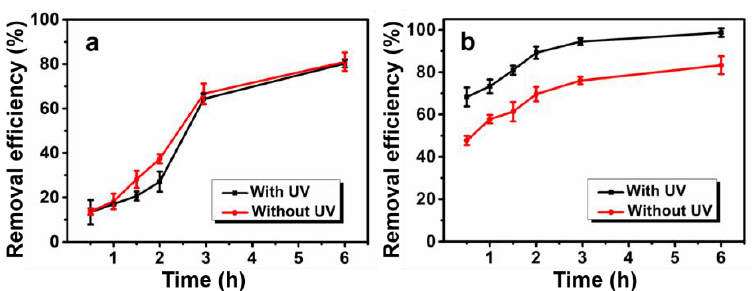
Figure 9. Effect of UV on dye degradation: ( a ) free laccase; ( b ) immobilized Lac. Figure 9. E ff ect of UV on dye degradation: ( a ) free laccase; ( b ) immobilized